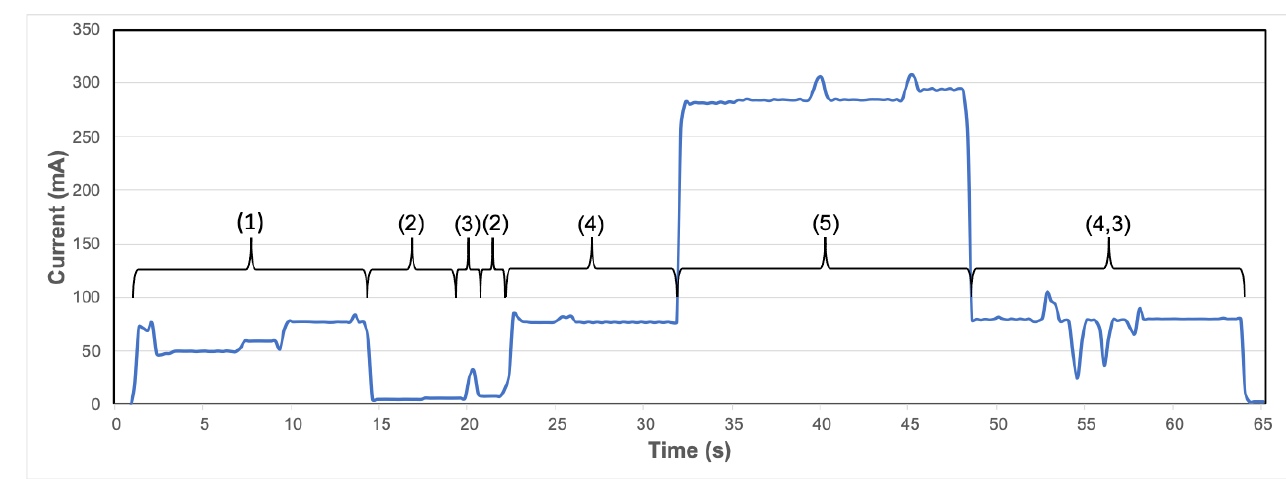
Figure 5. Node A—mode (i): NTP sync, sensor reading and data sending (once every 24 h).